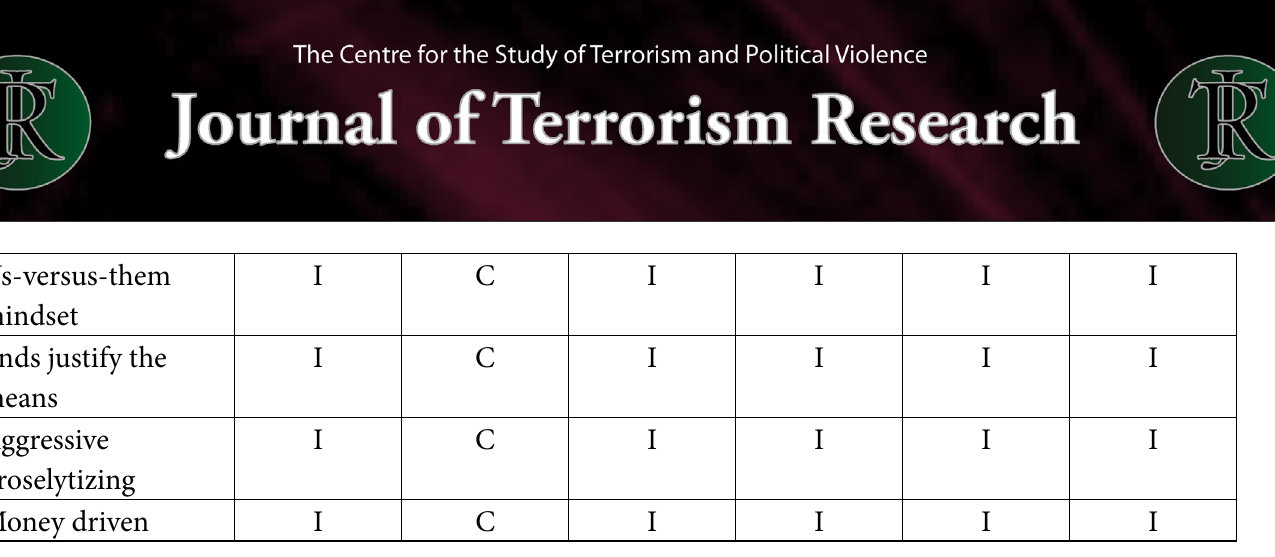
Table 5: Analysis of Competing Hypotheses This analysis fails to identify any singular evidence that is consistent (C) or inconsistent (I) across all of the hypotheses. Conversely, evidence abounds that is inconsistent with the hypotheses that ISIS is not a religion- based organization ( H1 ), ISIS is a sub-sect ( H4 ), ISIS is a sect ( H5 ), and ISIS is an accepted religion ( H6 ). Of the two remaining hypotheses, the evidence is minimal for ISIS being a movement ( H3 ) whereas the evidence is entirely consistent with ISIS being a cult ( H2 ). Therefore, the ACH supports the hypothesis. The results of the analyses suggest ISIS falls far to the left on the Islamic typological continuum and supports the hypothesis ISIS is a cult. Although the analyses support the hypothesis rather than the null hypothesis, the terms apocalyptic and Islamic must still be